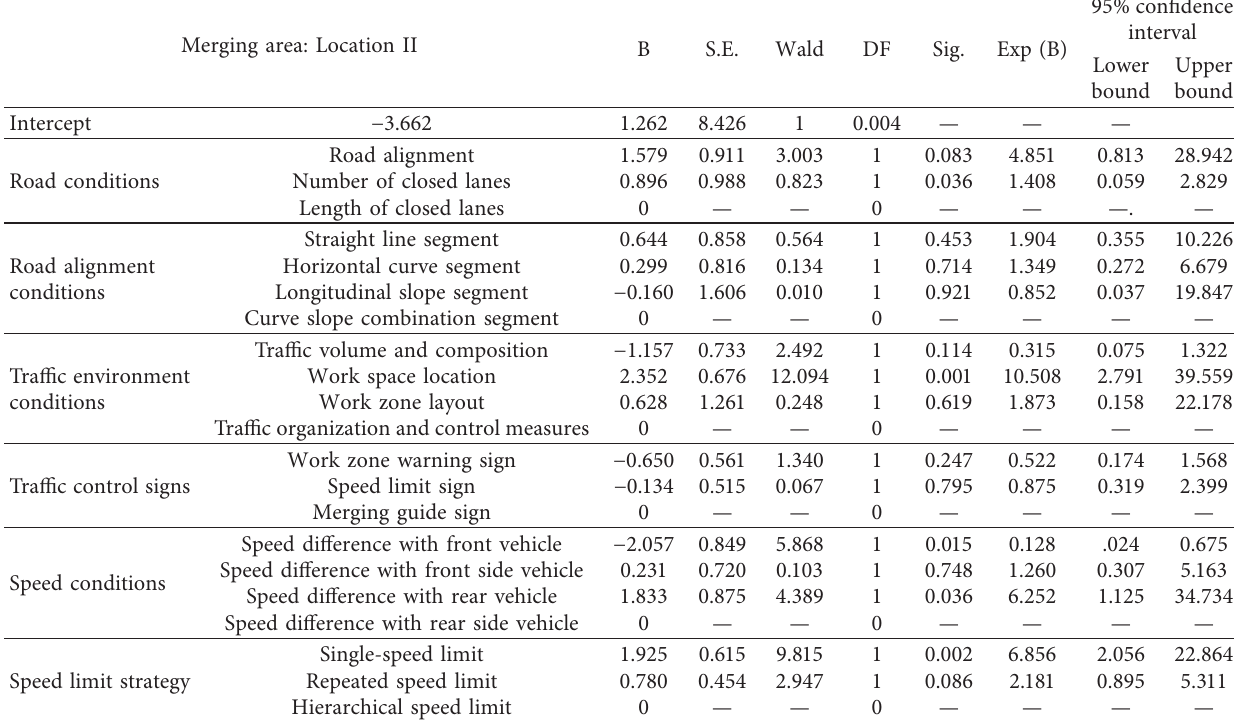
Table 5: Logistic regression model estimation results for Location II.